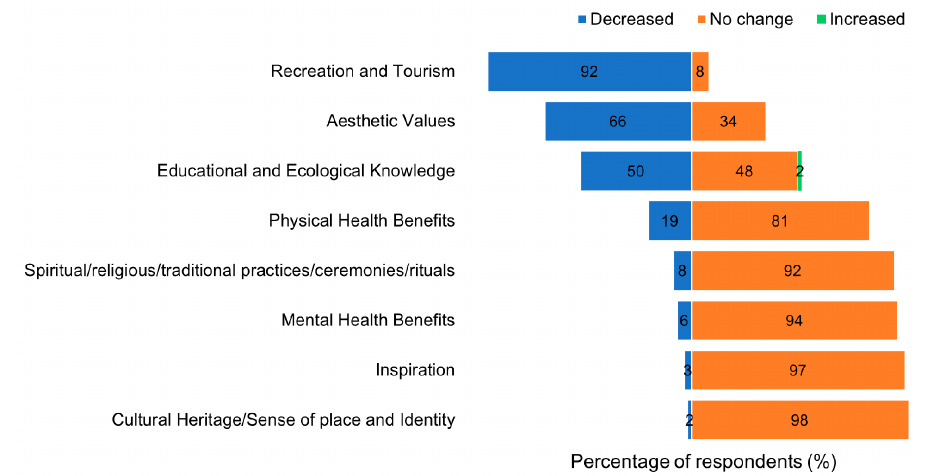
Figure 8. Observed changes in CES in both study sites in the Beas River overtime.